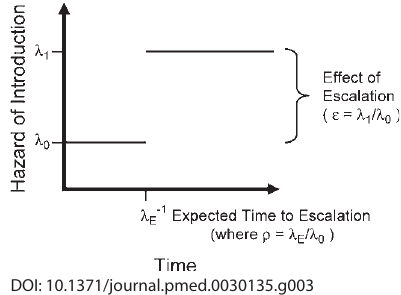
Figure 3. Schematic Diagram of the Escalating Hazard of Introduction Model with Time on the Horizontal Axis and Hazard of Introduction of a Pandemic- Capable Strain on the Vertical Axis The initial hazard of introduction (λ 0 ) increases to a higher hazard of introduction (λ 1 ) at a rate determined by the hazard of escalation (λ ) . The expected time of escalation is E the reciprocal of the hazard of escalation. The effect of escalation on the hazard of introduction is measured by the ratio of the fi nal to the initial hazards of introduction (ε = λ /λ ) 1 0